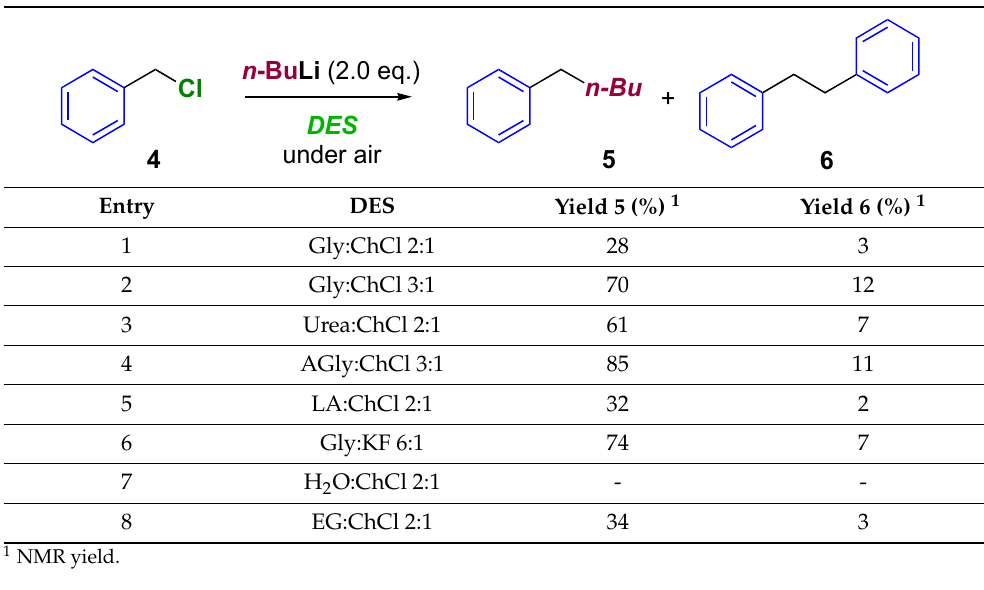
Table 3. Screening of different DESs as reaction media for the nucleophilic substitution of n -BuLi on benzyl chloride 4 .